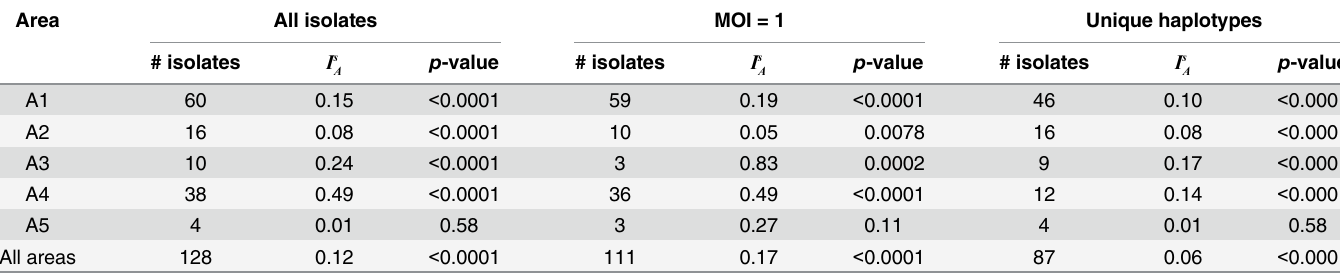
LD analysis for each area at three levels: all isolates, monoclonal isolates only (MOI = 1) and unique haplotypes only. p -Values to test the null hypothesis of linkage equilibrium. Isolates with missing alleles were excluded from the